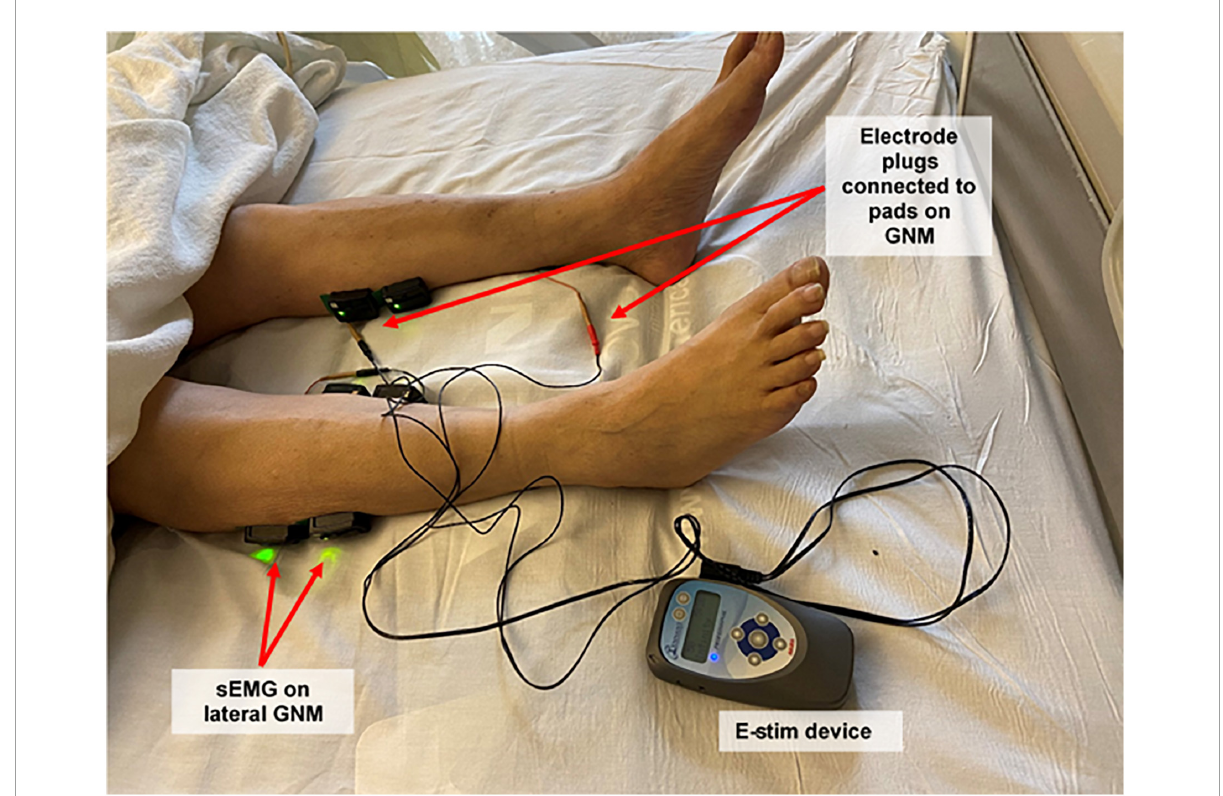
FIGURE1 Study setup: electrical stimulation device, plugs and pads, and surface electromyography sensors. Participants received electrical stimulation through electrode adhesive pads placed on both proximal and distal gastrocnemius muscles using a bio-electric stimulation technology R (cid:13) (BEST) micro-current platform (Tennant Biomodulator R (cid:13) ). Electrical stimulation (E-Stim) was active in the intervention group and non-functional in the control group. Two surface electromyography (Delsys Trigno Wireless EMG System, MA, USA) sensors were placed on the proximal lateral gastrocnemius of each lower extremity to evaluate muscular outcomes. Proximal medial gastrocnemius signal was also recorded, but not included for analysis. sEMG, surface electromyogram; GNM, gastrocnemius muscle; E-Stim, electrical